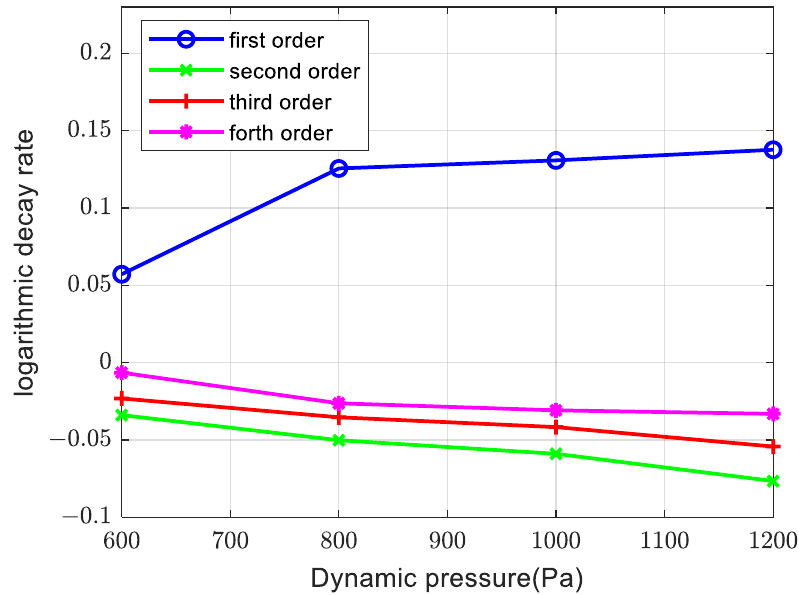
Figure 19. Variations in the logarithmic decay rate of generalized displacement with the dynamic pressure ( Ma = 0.4, α = 45 ◦